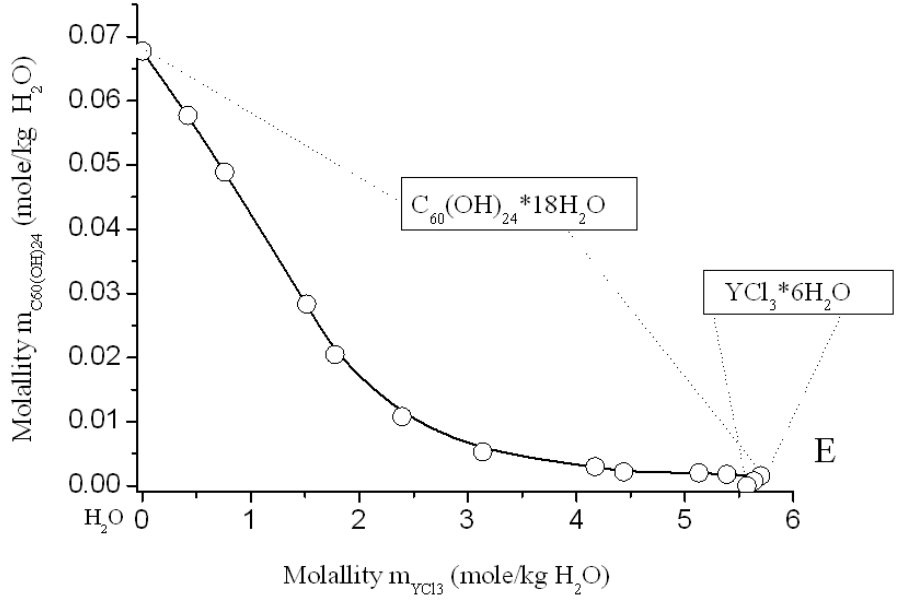
Figure 8. Solubility diagram in ternary system С 60 (ОН) 24 —NdCl 3 —H 2 O at 25 °C.